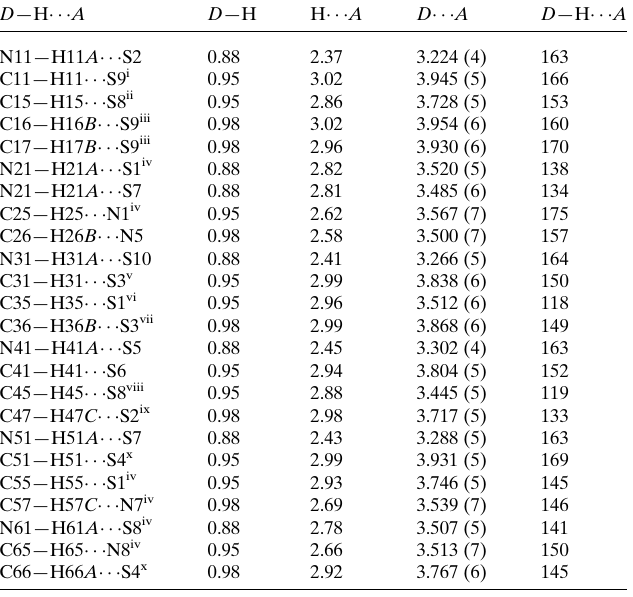
Table 4 Hydrogen-bond geometry (A˚ , (cid:3) ) for 2 .